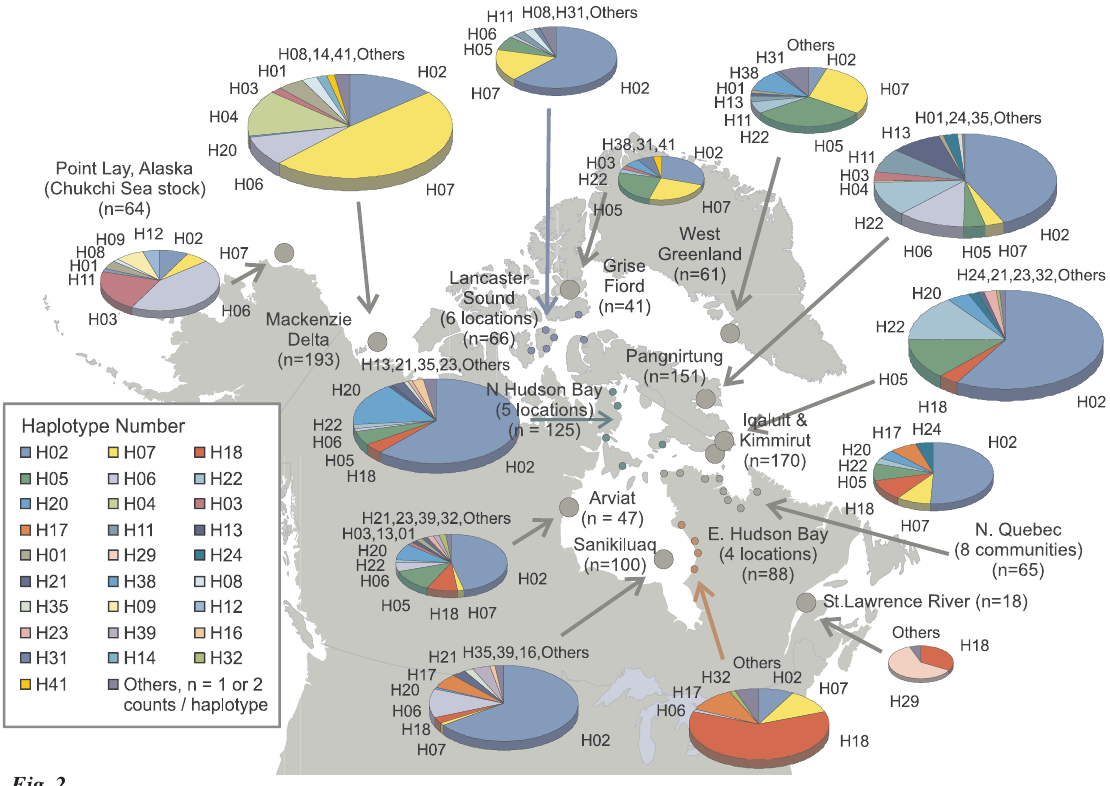
Fig. 2 Beluga mtDNA haplotype frequencies at 13 locations in North America and Greenland. Areas of the pies are proportional to sample size.